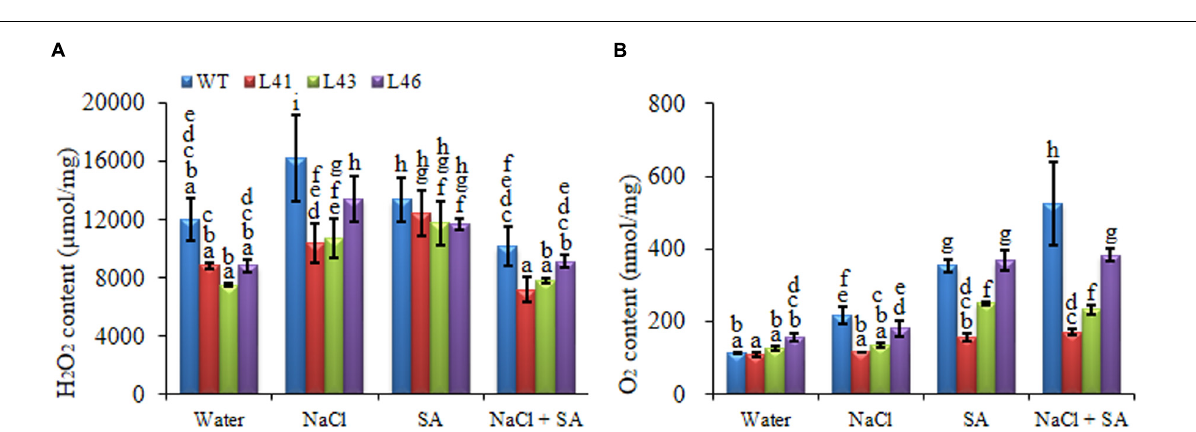
FIGURE 6 | Quantification of (A) H 2 O 2 and (B) O •− in leaves of WT and transgenic lines in the presence of 0, 200 mM NaCl, 150 µ M SA, and combined 2 NaCl + SA stress. Values are represented as mean ± SD ( n = 3) and marked with different alphabets to indicate significant difference at P ≤ 0.05